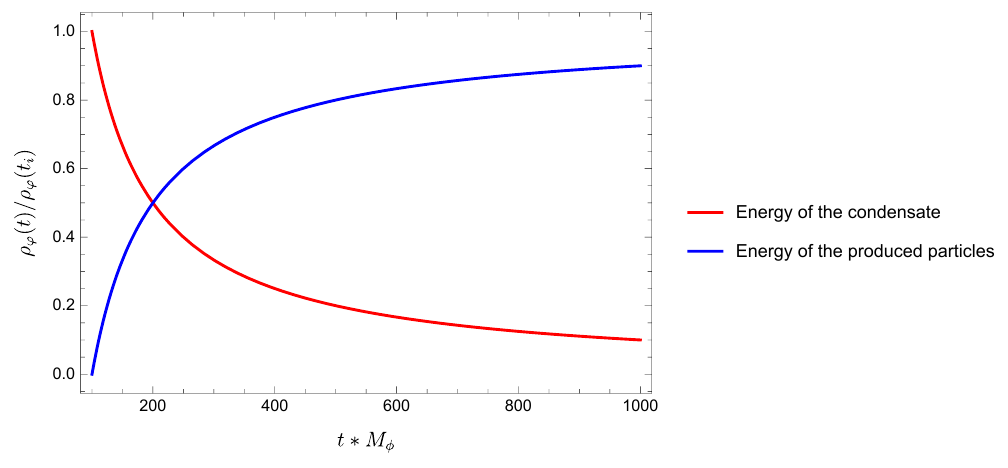
Figure 2 . Energy transfer from the condensate to the produced particles in a static universe without the self-energy correction. The evolution of the condensate energy density and the produced particles are shown by the red and blue lines, respectively. We take σ = 0 . 01 /M φ and the initial conditions at t i M φ = 100 as ϕ ( t i ) /M φ = 1 and ˙ ϕ ( t i ) = 0 (the same initial conditions are used in all the plots below). The energy of the condensate can be fully transferred to the produced